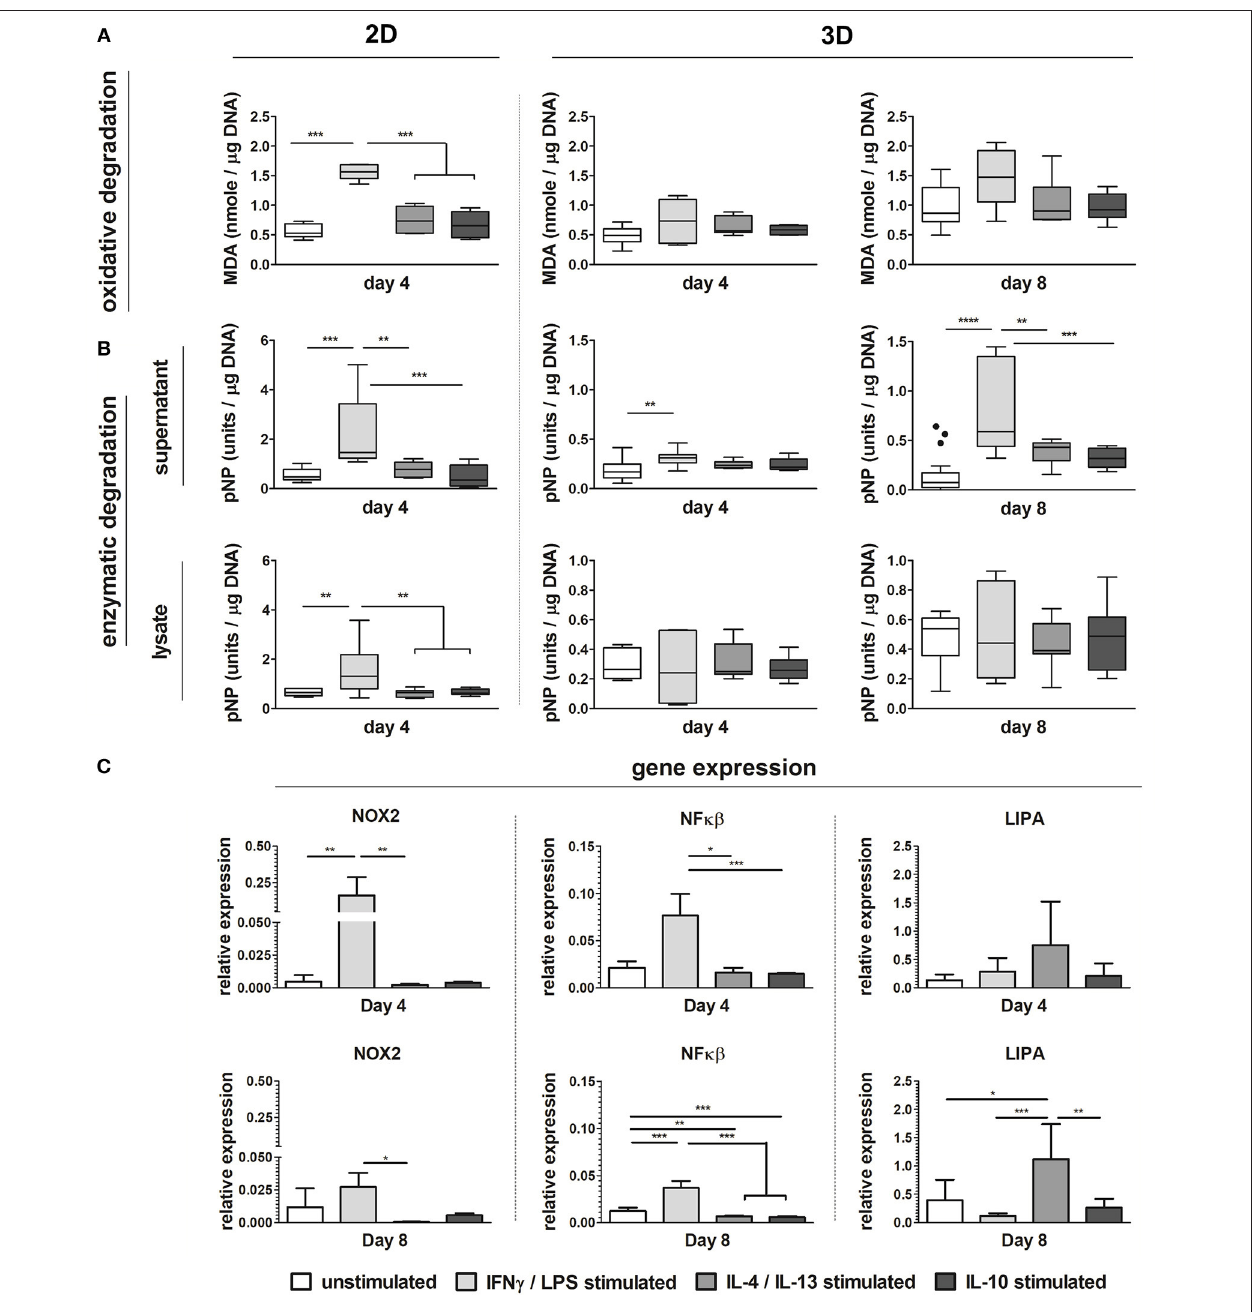
FIGURE 8 | Macrophage phenotype-driven biomaterial degradation. Boxplots visualizing MDA production (oxidative stress) of unpolarized macrophages (M0), LPS/IFN- γ stimulated macrophages (M1), IL-4/IL-13 stimulated macrophages (M2a), and IL-10 stimulated macrophages (M2c) cultured up to 4 days on tissue culture treated well plates (“2D”) or on scaffolds with 6 µ m Ø isotropic fibers (“3D”) for 4 days and 8 days (A) . Enzymatic activity detected in the supernatant and cell lysate of M0, M1, M2a, and M2c macrophages cultured up to day 4 (2D and 3D) and day 8 (3D) (1 unit = 1 nmol pNP released from pNPB per minute) (B) . Gene expression (compared to GAPDH) of NOX2, NF κ B, and LIPA for M0, M1, M2a, and M2c macrophages cultured on scaffolds with 6 µ m Ø isotropic fibers (C) . MDA and enzyme activity values are corrected for DNA content. * p < 0.05; ** p < 0.01; *** p < 0.001. N ≥ 4/group/time point.